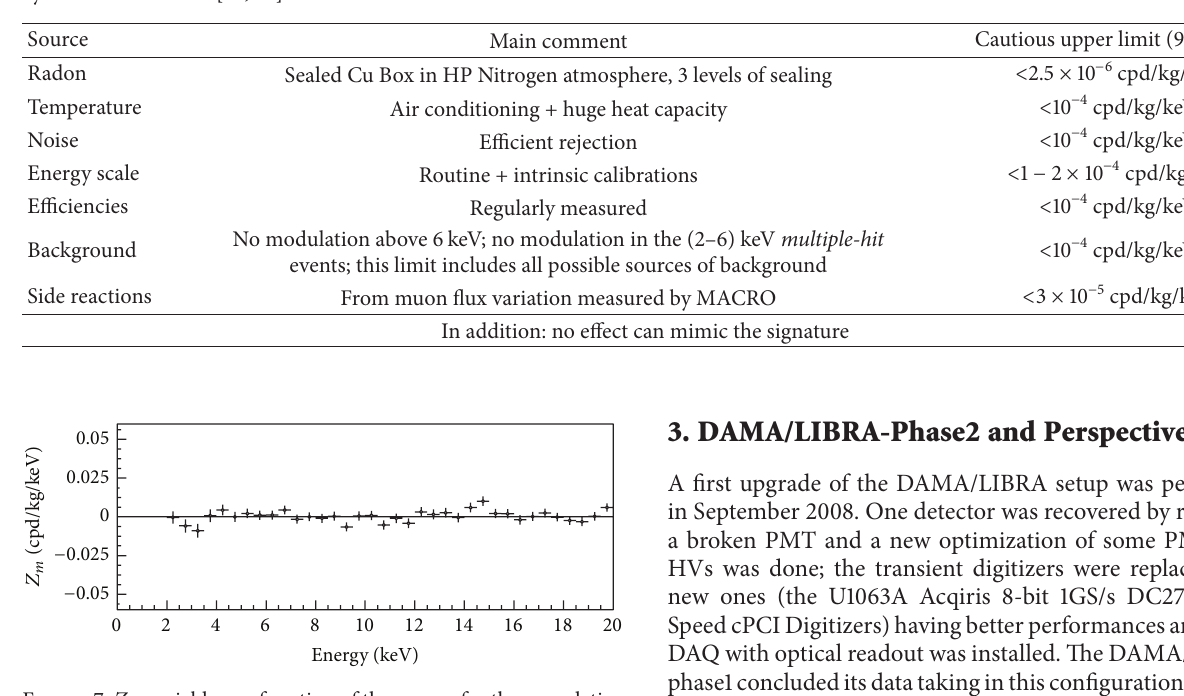
Figure 7: 𝑍 𝑚 variable as a function of the energy for the cumulative exposure of DAMA/NaI and DAMA/LIBRA-phase1, once setting 𝑆 𝑚 in (1) to zero. The energy bin is 0.5 keV. The 𝑍 𝑚 values are expected to be zero. The 𝜒 2 test applied to the data supports the hypothesis that the 𝑍 𝑚 values are simply fluctuating around zero. See text.